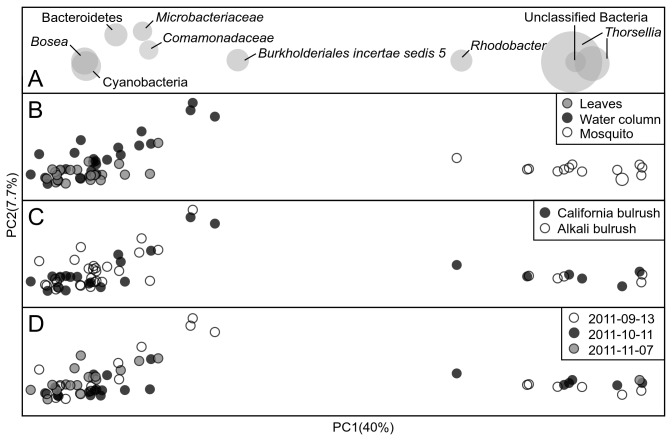
Taxonomic profiling of mosquito-water-plant microbiome profiles.PCoA plots of weighted UniFrac distances of bacterial communities in mosquitoes, water and leaf samples from mesocosms containing the two bulrushes (alkali and California bulrushes) from the three sampling dates. Panel A shows the OTUs associated with that region on the plot, scaled based on sequence abundance. Panel B shows a PCoA plot based on three DNA sources (mosquitoes, water and plant leaves), Panel C recolors samples of Panel B to highlight two plant species, Panel D recolors the same samples based on the three sample dates.